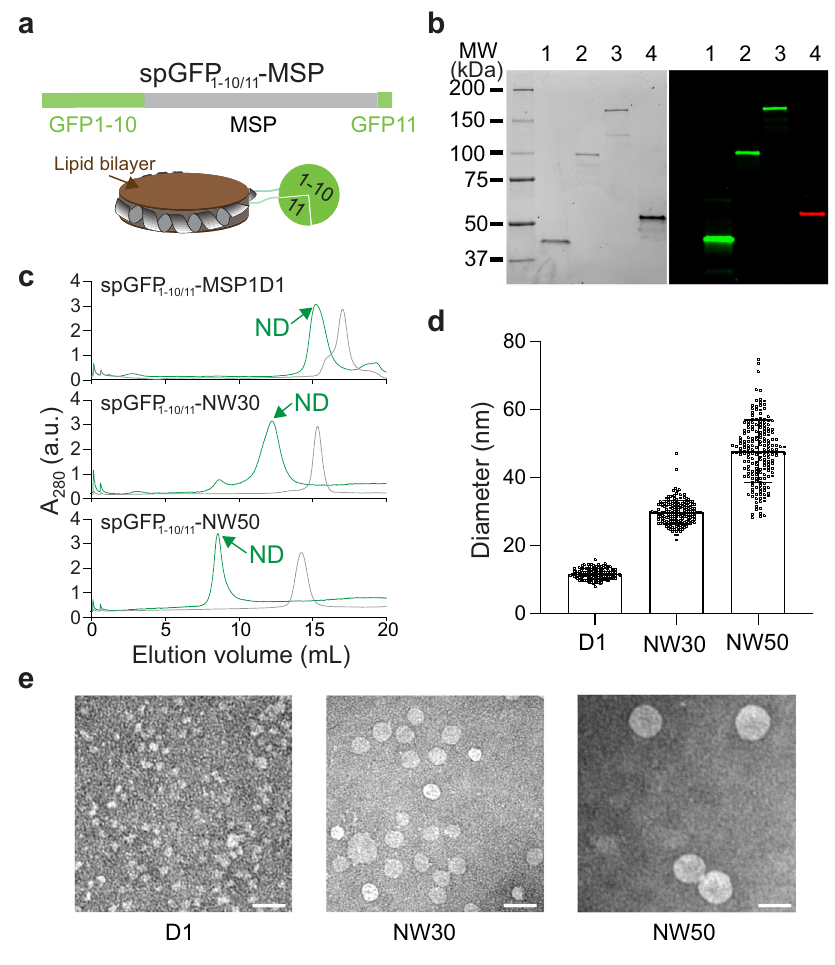
Fig. 1 Circularization of nanodiscs by GFP complementation. a Illustration of isenND. Split GFP enables the circularization of the spGFP 1-10/11 -MSP1D1 protein (top) and nanodisc (bottom). b SDS-PAGE (left, Coomassie-blue stained) and in-gel fl uorescent imaging analysis (right) of circularized MSPs. 1 , spGFP 1-10/11 -MSP1D1; 2 , spGFP 1-10/11 -NW30; 3 , spGFP 1-10/11 -NW50; 4 , SPY_spmcherry1 1-10/11 -MSP1D1. c Representative SEC pro fi les of the indicated MSPs (gray) and nanodiscs (ND, green). For nanodisc reconstitution, protein:lipid ratios were: 1:60 for spGFP 1-10/11 -MSP1D1, 1:200 for spGFP 1-10/11 -NW30, 1:400 for spGFP 1-10/11 -NW50. d Diameters of split GFP circularized nanodiscs determined by negative-stain EM. D1 , spGFP 1-10/11 -MSP1D1; NW30 , spGFP 1-10/11 - NW30; NW50 , spGFP 1-10/11 -NW50. Data are shown as mean ± s.d. from multiple measurements using n ≥ 3 independent sample preparations. e Representative EM micrographs of split GFP circularized nanodiscs. Scale bar, 50 nm.